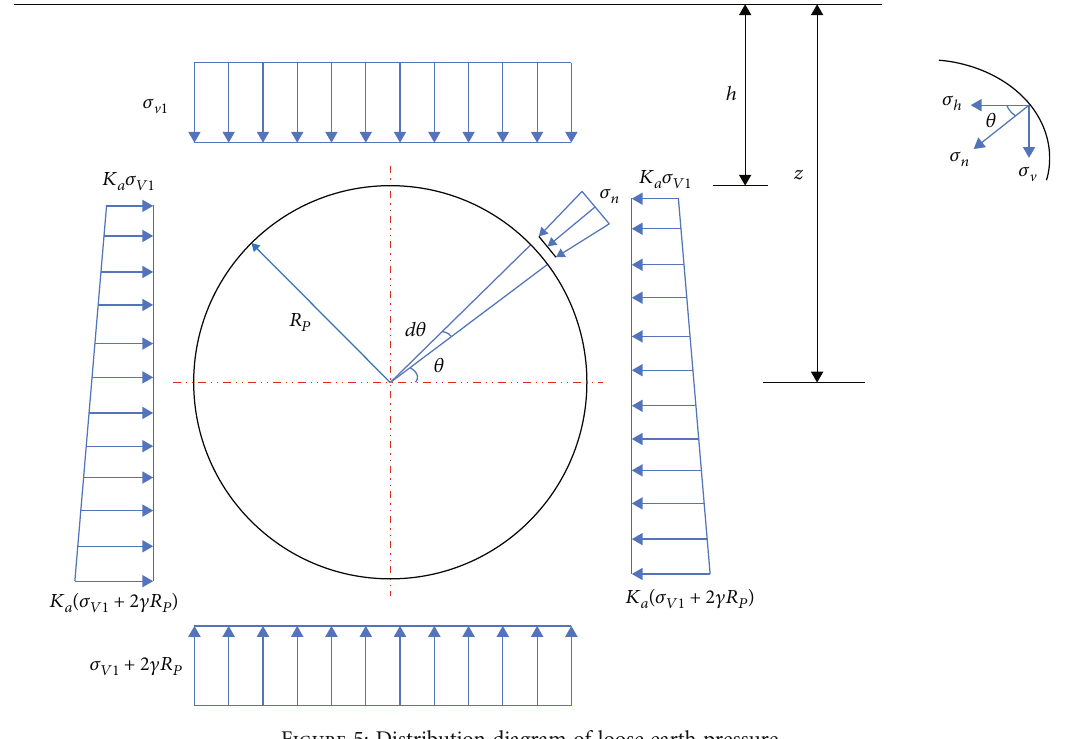
Figure 5: Distribution diagram of loose earth pressure.